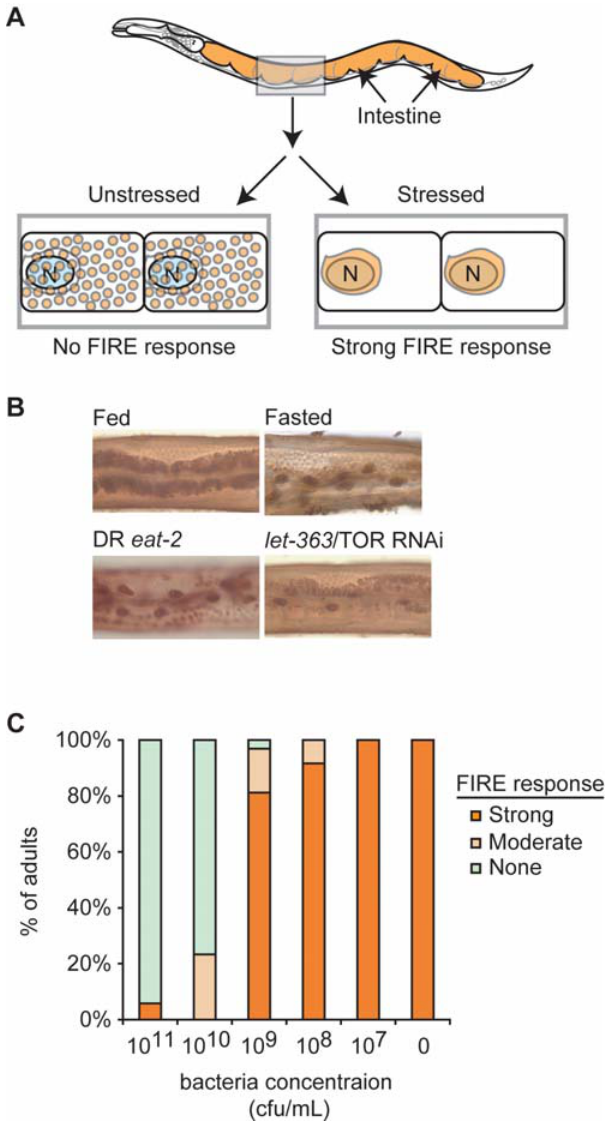
Figure 1. Dietary restriction (DR) induces the FIRE response to cellular stress in C.elegansintestinal cells. (A) Cartoon of the FIRE response depicting the stress-induced redistribution of cytoplasmic esterase activity to a perinuclear region. The large rectangles contain cartoons of esterase activity (brown color) localization in two adjacent intestinal cells (rounded rectangles) with nuclei indicated by ovals labeled ‘‘N’’. (B) Cytoplasmic esterase activity in intestinal cells of young adult hermaphrodites in the presence of ample bacterial food (Fed), 5- hours following food withdrawal (Fasted), and in eat-2(ad465) mutants (DR eat-2 ) or wildtype animals subjected to RNAi knockdown of let-363 / TOR ( let-363 /TOR RNAi). Images are representative from 80 or more animals examined in at least 3 independent experiments. (C) DR induced by food source dilution also induced a FIRE response in wildtype adults. Young adult hermaphrodites, raised under bacteria- replete conditions, were fed with bacteria at indicated concentration for 5 hours and then analyzed. At high food concentrations (10 10 and 10 11 cfu/mL) adult animals did not exhibit a FIRE response. At lower food concentrations, ( , 10 9 cfu/mL), most animals exhibited a strong FIRE response. For each feeding condition, FIRE response was scored in 17- 32 animals in a blinded fashion. Similar results were obtained in 2 additional experiments using a progressive nutrient stress regimen of diluted let-363 /TOR RNAi (not